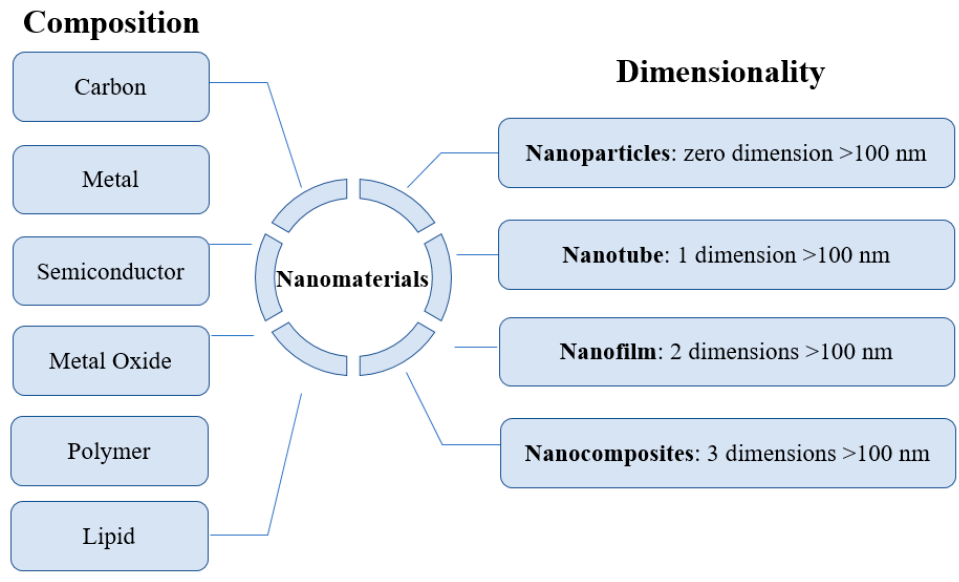
Figure 1. Classification of nanomaterials based on composition and dimensionality.